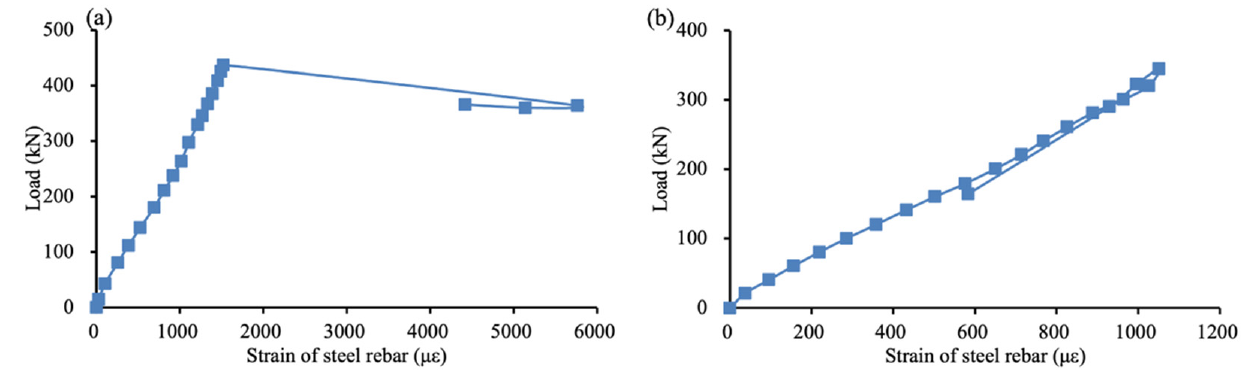
Figure 8. Load–strain relation of steel reinforcement bar in specimen: ( a ) 10 × 60 @ 100 and ( b ) 20 × 30 @ 150.